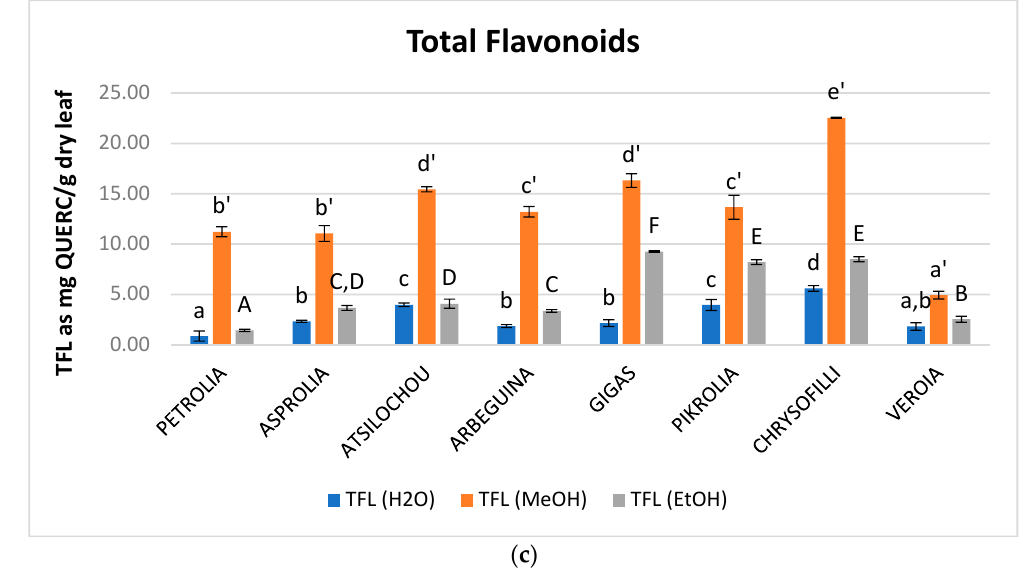
Figure 3. Content in total ( a ) hydroxycinnamic acid derivatives (THAD), ( b ) flavonols (TFLVN), and ( c ) flavonoids (TFL) of aqueous, methanol, and ethanol olive leaf (OLF) extracts; different letters (a–f, a’–e’, A–F) indicate statistical significant differences